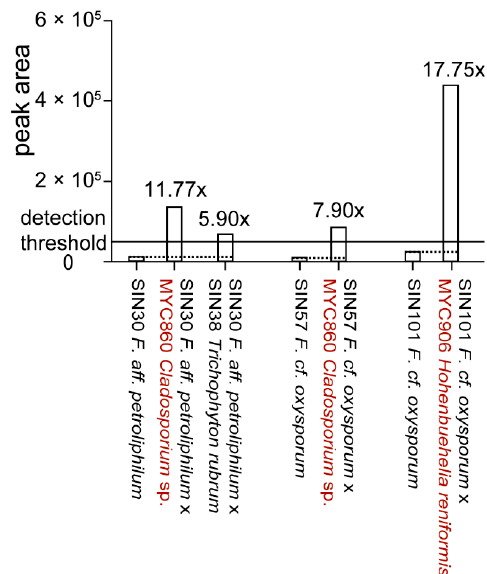
Figure 6. De novo induction of fusaric acid upon co-culture. Estimation of fold change variations was calculated based on extracted peak area of fusaric acid for the UHPLC-TOFMS metabolite profiles. Co-cultures in which fusaric acid production is induced are shown in comparison to fusaric acid production in the respective pure culture. Co-cultures showing upregulation are shown in Supplementary Figure S2. All strains are of human origin, except MYC860 and MYC906 (highlighted in